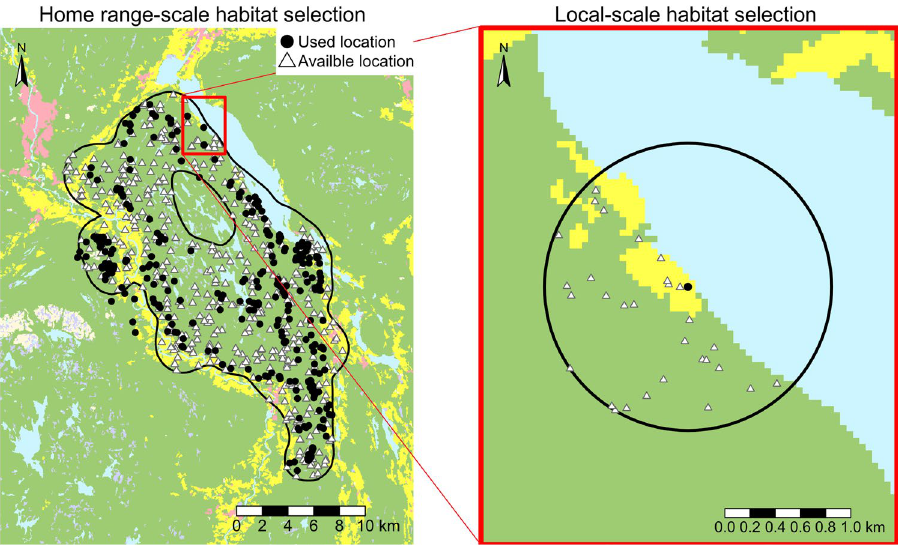
Figure 3. Illustration of the different scales and availability definitions. For the home range-scale analysis (left map) we sampled 30 available locations per used location inside the home range of the lynx (for illustration purposes we used a ratio of 1:1 in the left map). While for the local-scale analysis (right map) we sampled 30 available locations inside a buffer with the radius equal to the mean step length (distance between two consecutive locations) of the lynx (for illustration purposes we removed two buffers and their corresponding points in the right map). The figure was created using the R package tmap (version 3.2, https:// cran.r- proje ct. org/ web/ packa ges/ tmap/ index.